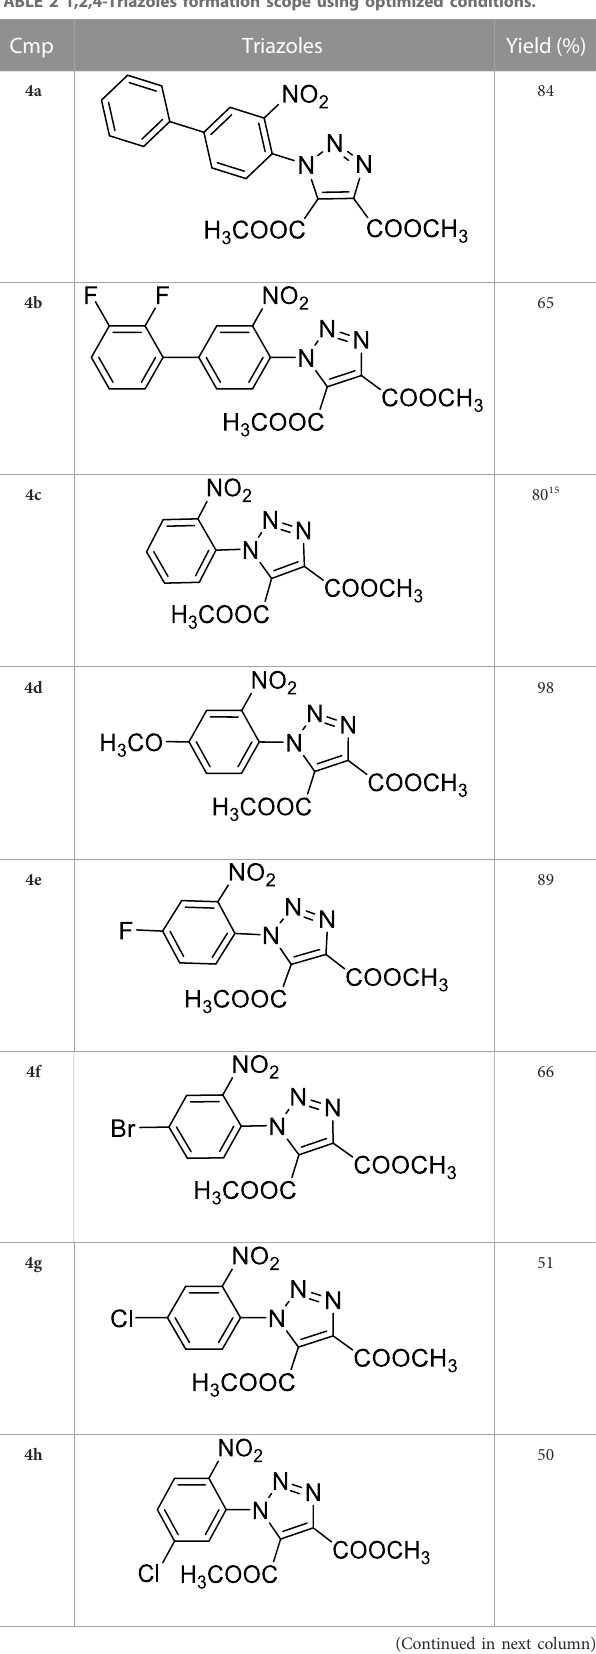
TABLE 2 1,2,4-Triazoles formation scope using optimized